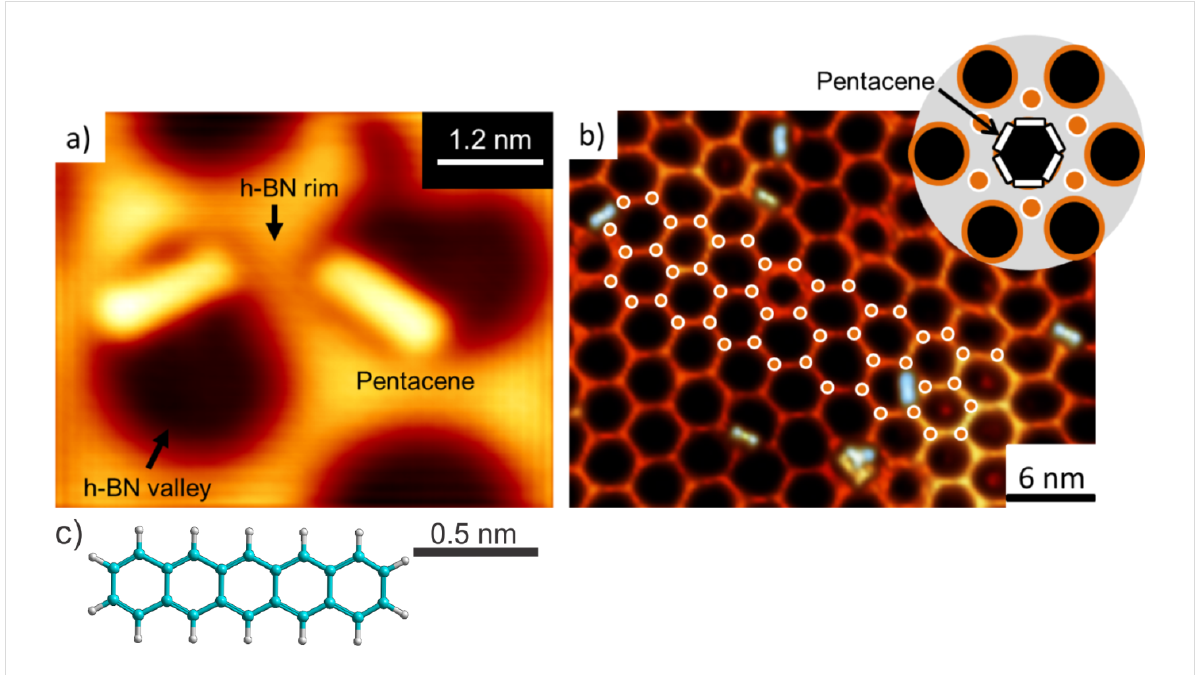
Figure 1: a) STM topography image of pentacene on h-BN ( U = − 1 V , I = 50 pA). b) Large-scale STM topography image of pentacene on h-BN. The white circles indicate the preferential adsorption sites illustrated in the inset. Inset: Illustration of the six possible pentacene adsorption geometries inside the h-BN valley ( U = − 1 V, I = 50 pA). c) Representation of the molecular geometry of a free pentacene